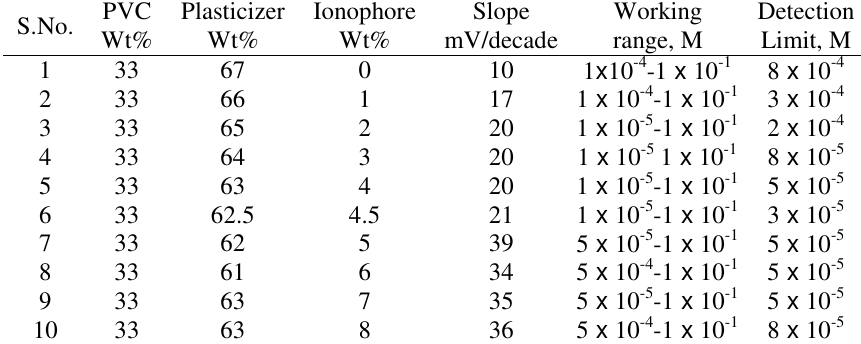
Table 1. Optimization of membrane ingredients for DB24C8 based membranes